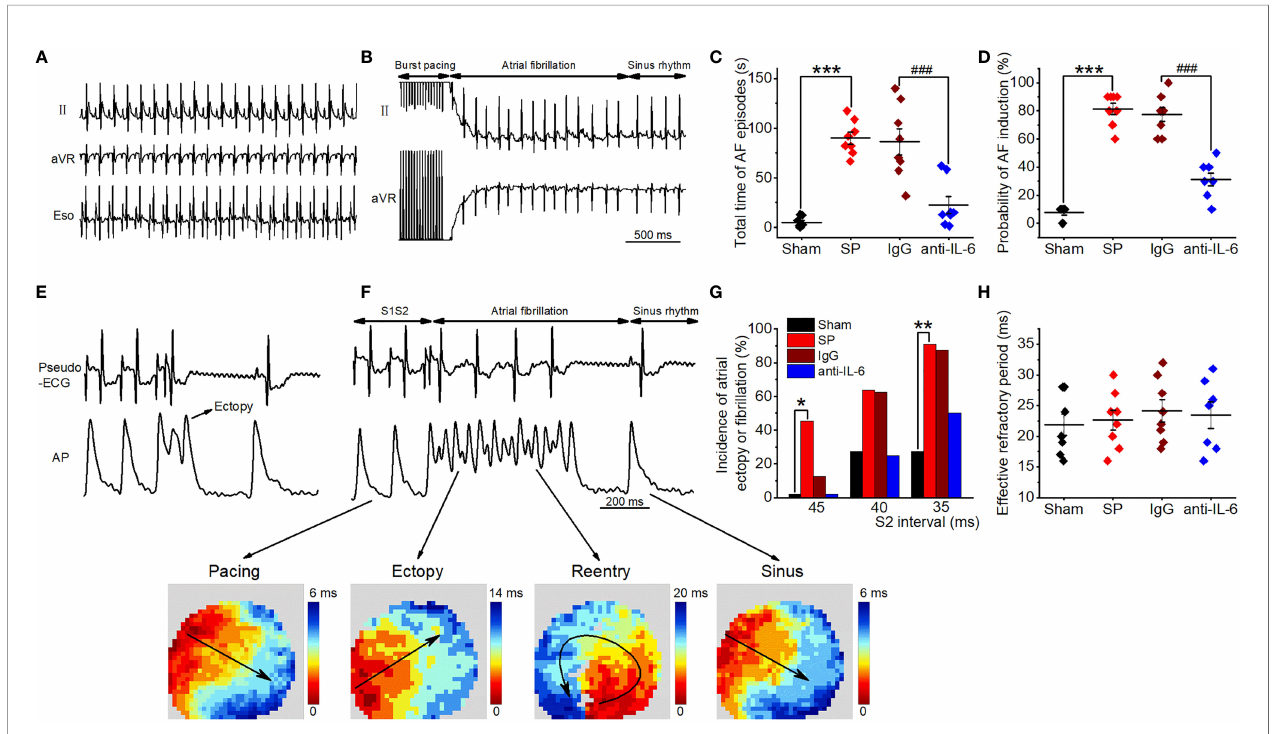
FIGURE 1 | IL-6 neutralization reduces AF induction and duration in SP rats. (A) Representative recordings of surface and esophageal ECG during sinus rhythm. (B) Representative recordings of AF ECG followed by burst pacing in the SP group. (C, D) Statistical results of AF duration (C) and probability (D) in the Sham, SP, IgG, and anti-IL-6 groups. n = 8/group. (E, F) Representative AP trace and ECG recorded from an SP rat, showing atrial ectopy (E) and fi brillation ( F , upper panel) induced by an extrastimulus (S1S2; S2 intervals ranging from 45 to 35 ms) method. Activation maps of pacing, ectopy, reentry, and sinus rhythm ( F , lower panel) corresponding to the AP trace. (G) Incidence of atrial ectopy or fi brillation for each S2 interval. Sham, n = 11; SP, n = 11; IgG, n = 8; anti-IL-6, n = 8. (H) Quanti fi cation of atrial effective refractory period. Sham n = 9; vehicle n = 8; IgG, n = 8; anti-IL-6, n = 7. Statistical analyses: c 2 test for incidence, Student t-test or one-way ANOVA with Bonferroni ’ s post-hoc test for the rest. * P < 0.05, ** P < 0.01, *** P < 0.001 vs . Sham; ### P < 0.001 vs .